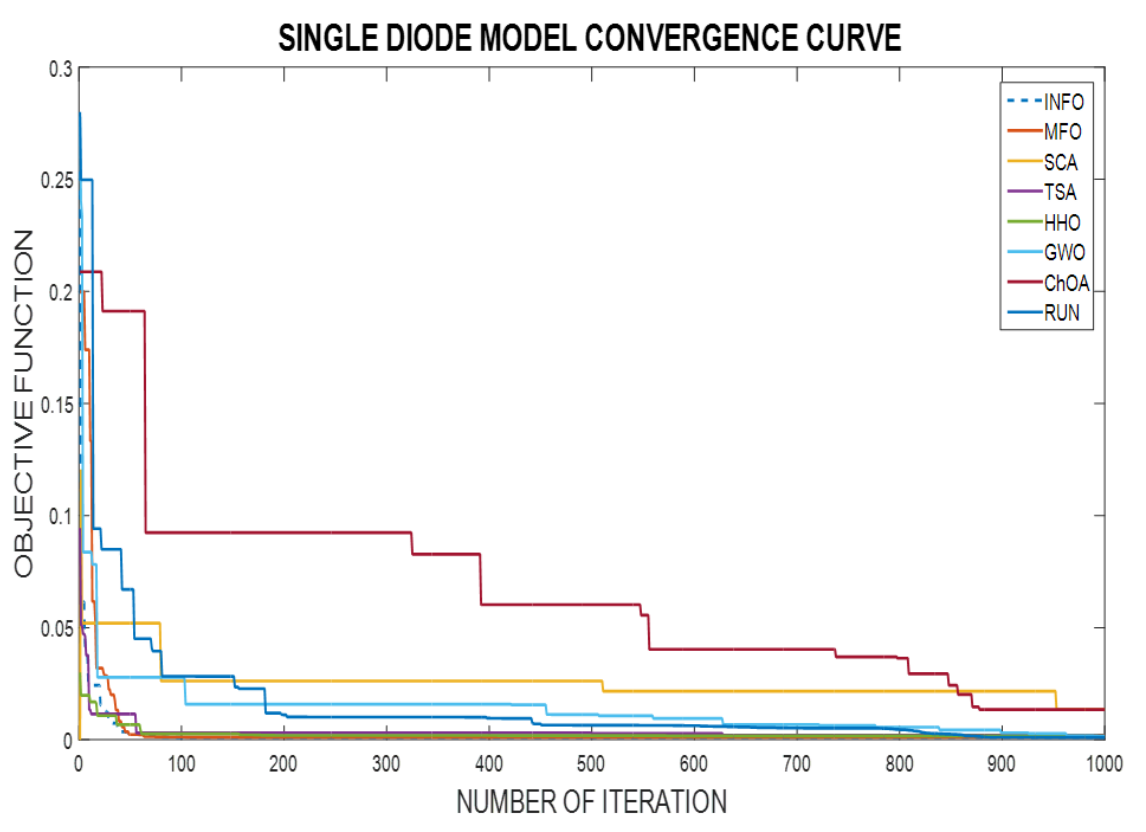
Figure 16. SDMSC convergence curve.